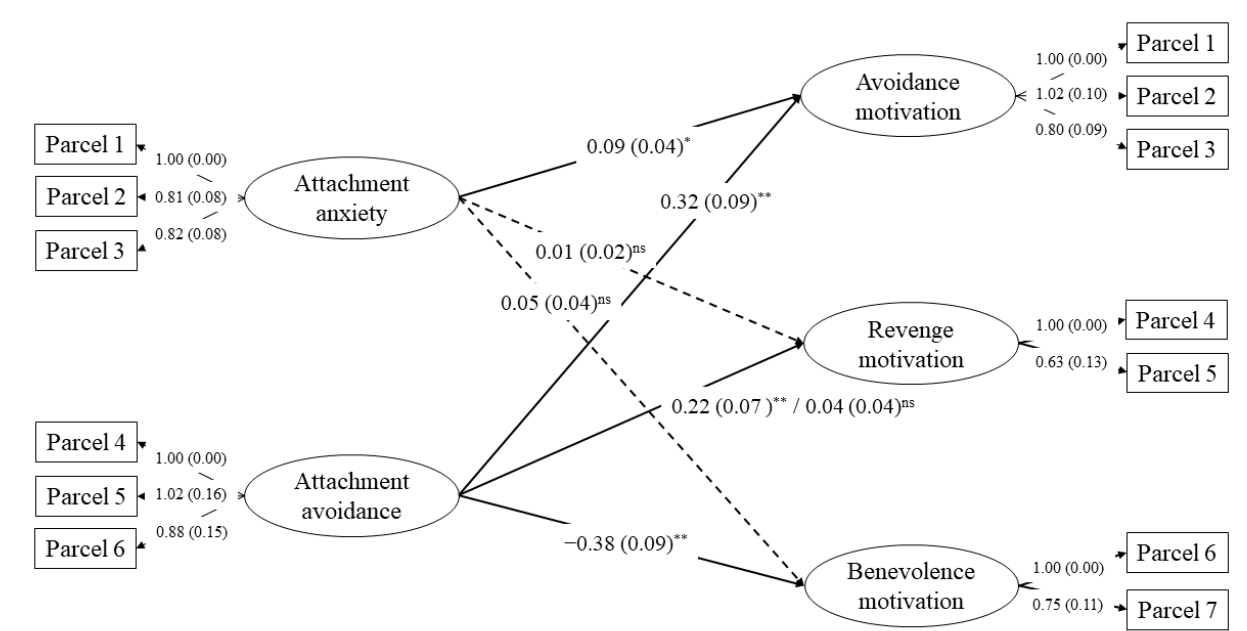
Figure 1. Final model with the noninvariant pathway freely estimated across gender. Note. Unstan- dardized estimates (standard errors) are shown. Correlations between variables, measurement errors and residuals are not shown to simplify presentation. Solid lines represent significant paths; dashed lines represent nonsignificant paths. Estimates before and after the slash refer to men and women, respectively. All factor loadings are significant at p < 0.001. ns p > 0.05. * p < 0.05. ** p ≤ 0.001.